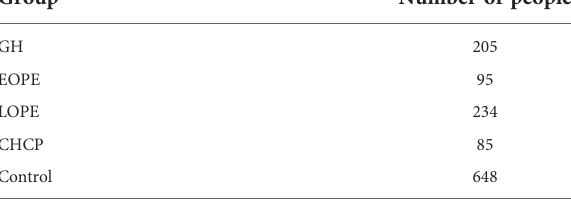
TABLE 3 Dynamic